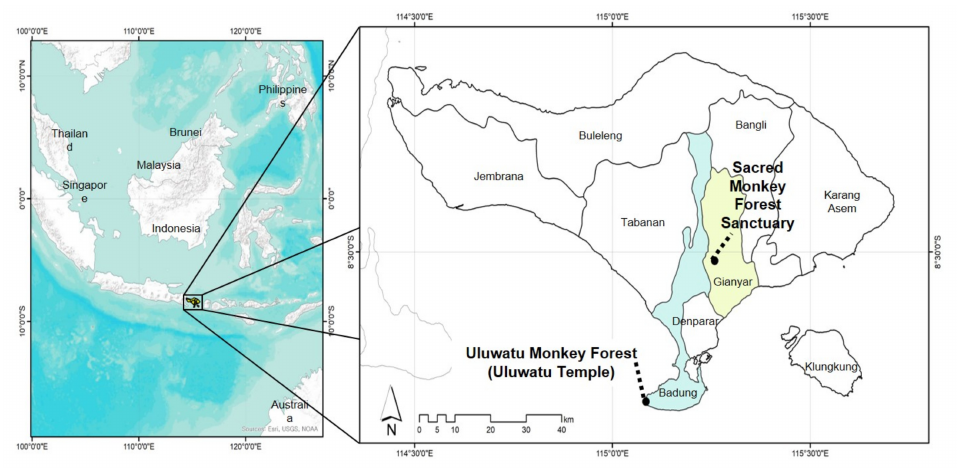
Figure 2. Research